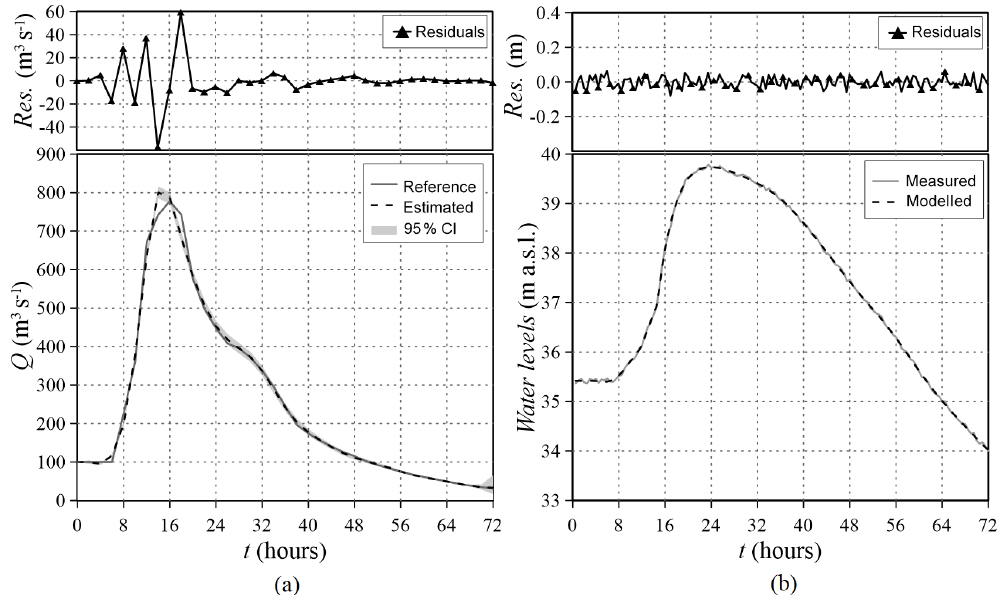
Figure 14. Secchia River: reference and estimated (with a 95% credibility interval) inflow hydrograph (a) and observed (corrupted) and modelled water levels (b) . The residuals between reference and estimated values are also reported. Table 5. Secchia River: characteristics of the simulation. Number of parameters N